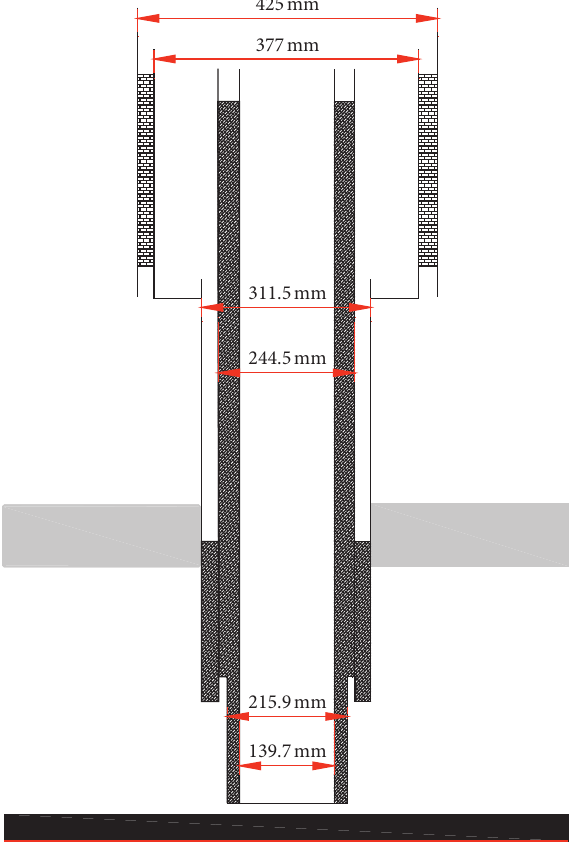
Figure 9: Schematic diagram of the fractured well